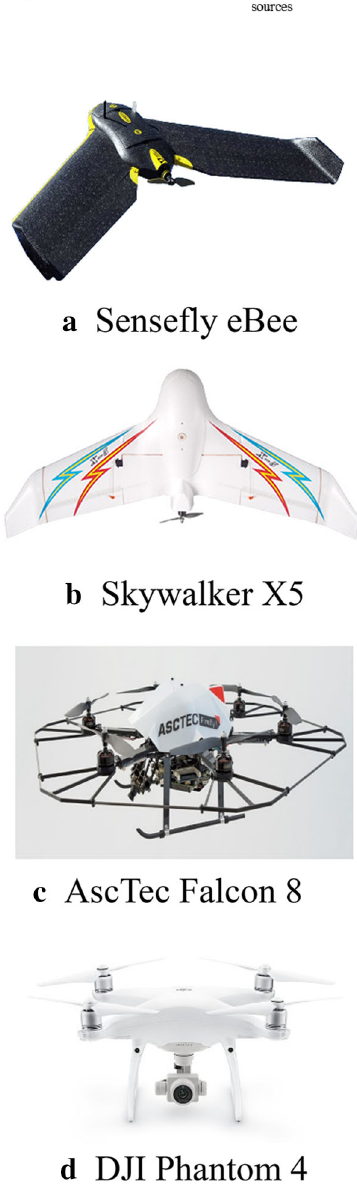
Fig. 3 UAV platforms (DJI Phantom series takes DJI Phantom 4 as an